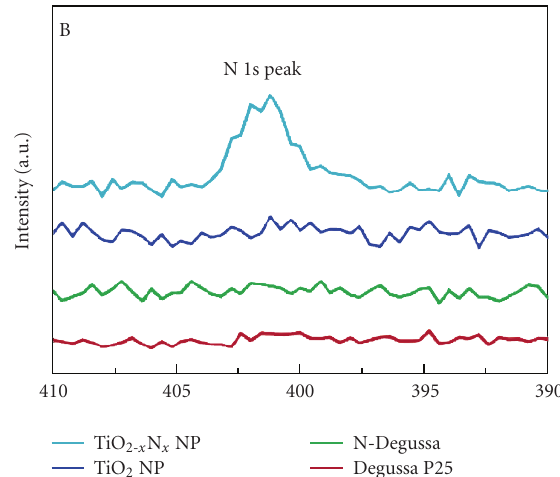
Figure 2: X-ray photoelectron spectra of various TiO 2 specimens; N-Degussa is nitrided P25 TiO 2 and TiO 2- x N x NP denotes TiO 2- x N x nanoparticles. Reproduced with permission from [21]. Copyright (2004) American Chemical